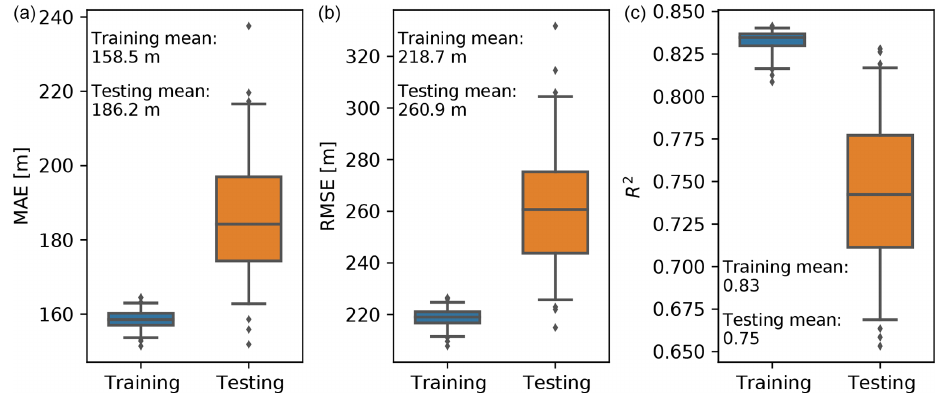
Figure 4. Box and whisker plots of the metrics, including the MAE (a) , RMSE (b) , and R 2 (c) , of the eXtreme Gradient Boosting (XGB) model on the training and testing datasets. The horizontal lines show the 2.5th, 25th, 50th, 75th, and 97.5th percentiles, and the mean values are labeled in the